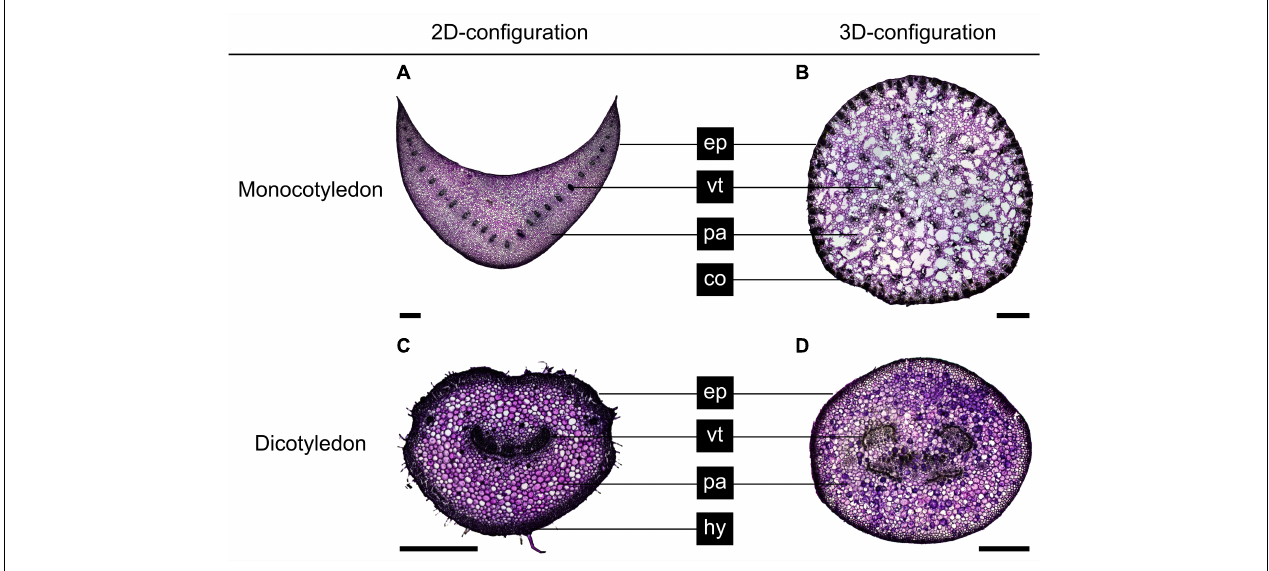
FIGURE 4 | Basal cross-sections of (A) Hosta × tardiana ‘El Niño’, (B) Caladium bicolor , (C) Hemigraphis alternata , and (D) Pilea peperomioides stained with toluidine blue O. Epidermis (ep), vascular tissue (vt), parenchyma (pa), collenchyma (co), and hypodermis (hy) are shown. Scale bars are 1 mm.